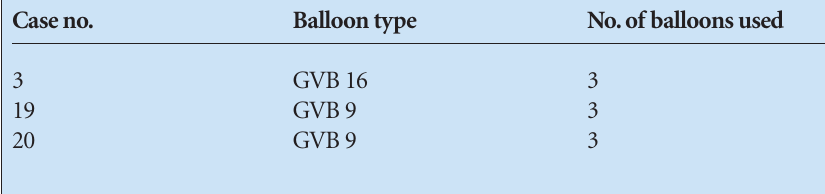
Table IV.Patients requiring more than one balloon to occlude the fistula Case no. Balloon type No.of balloons